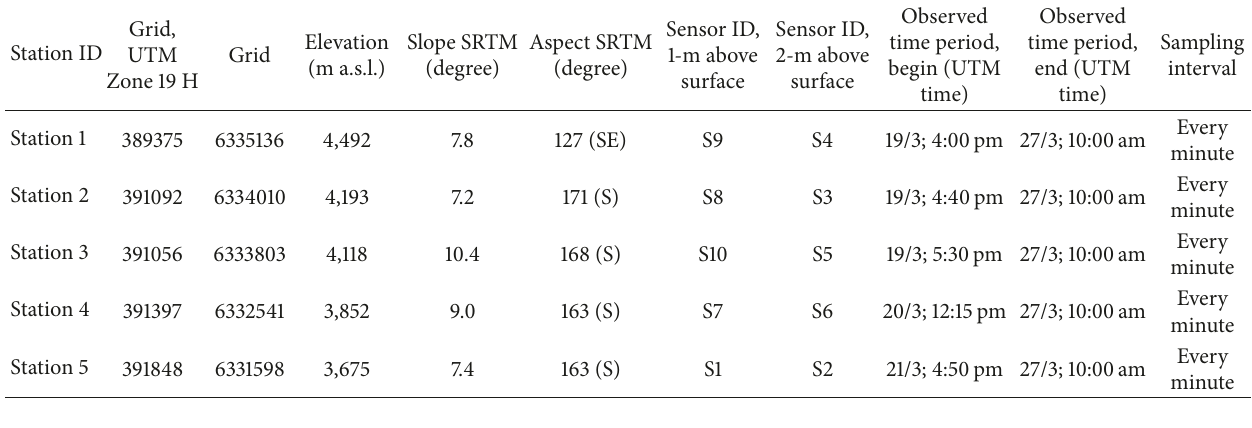
Table 1: Tinytag air temperature stations on Olivares Gamma Glacier. The surface elevation, slope, and aspect are obtained from the SRTM (Shuttle Radar Topography Mission), February 2000.